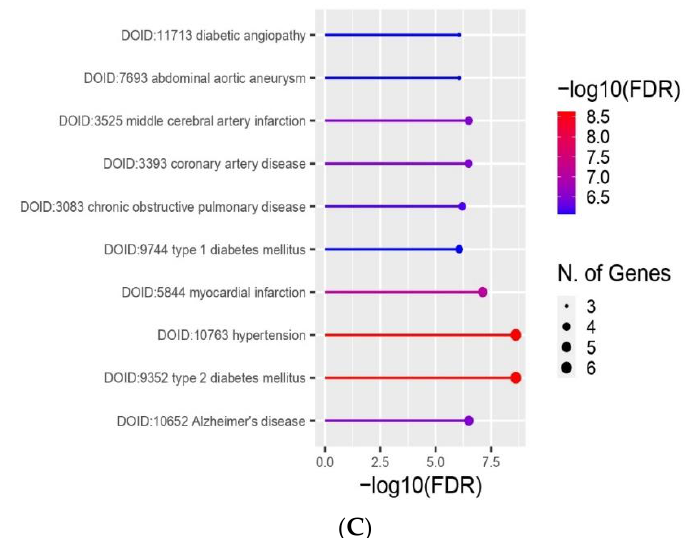
Figure 6. Bioinformatic analyses of genes/proteins involved in MEL effects in HEMA- and/or CQ-treated human dental pulp cells. A hierarchical clustering tree summarizing the correlation among proteins sharing subcellular localization in compartments. Compartments with many shared genes are clustered together ( A ). Predicted gene/protein interaction network of HMOX1, NOS2 (iNOS) SOD and CASP3. Nodes represent the genes/proteins connected by edges which represent functional relationships among them ( B ). GO Enrichment analysis results regarding involvement in diseases: the x-axis represents the number of genes enriched in each GO, and the y-axis represents the diseases involved ( C ). HMOX1 — heme oxygenase-1; CASP3 — caspase-3; NOS2 (iNOS) — inducible nitric oxide synthase; SOD-superoxide dismutase; known interactions from curated databases (blue line); known interactions experimentally determined (purple line); gene neighborhood (green line); gene co-expression (black line); text mining (yellow line); FDR is calculated based on nominal p -value from the hypergeometric test. Fold Enrichment is defined as the percentage of genes belonging to a pathway divided by the corresponding percentage in the background. Fold Enrichment indicates how genes of a certain pathway are overrepresented.